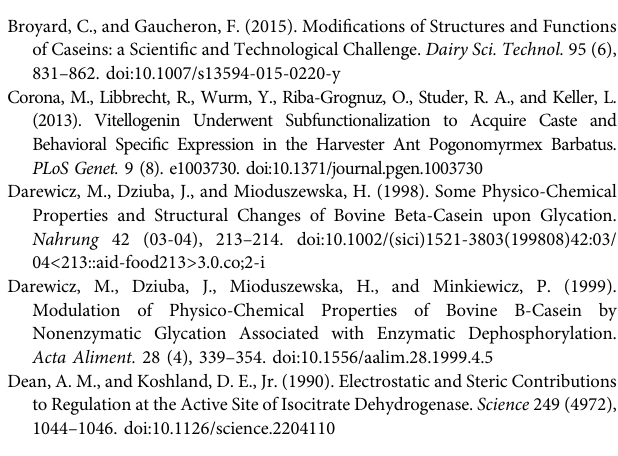
Supplementary Figure S3 | Eight electrostatic interactions connect the α -helical subdomain (green cartoon) to β 1 (blue cartoon, left) and β 2 (blue cartoon, left). The interactions ’ residues are shown here and colored according to charge (blue for positive charge and red for negative charge). Supplementary Figure S4 | The α -helix connecting β 1 and β 2 are shown for honey bee Vg, human MTP, lamprey Vg, and C. elegans Vg-2. The fi rst and last residue of the α -helices (red cartoon) are included and illustrate the length differences. The yellow β -strands before and after the α -helices represented the last and fi rst β -strand of β 1 and β 2, respectively. The dotted green line for MTP and lamprey Vg represents unresolved regions in diffraction